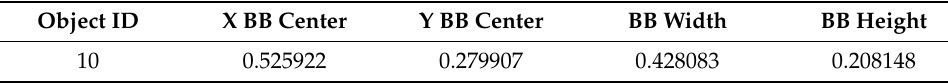
Table 4. Example of a .txt file with single annotation.